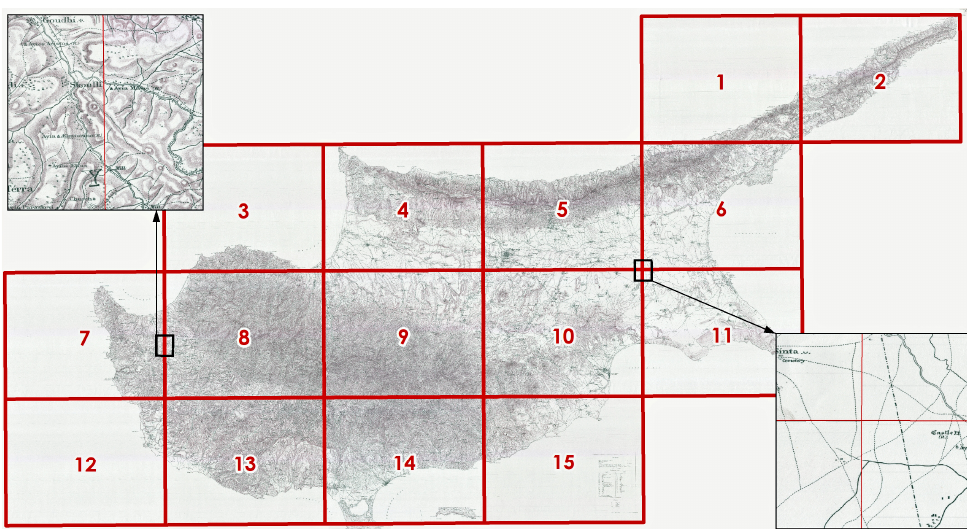
Figure 1. The 15 sheets of Kitchener’s map of Cyprus. The inset maps show details from the seamless mosaic (reproduced with the kind permission of the Sylvia Ioannou Charitable Foundation).